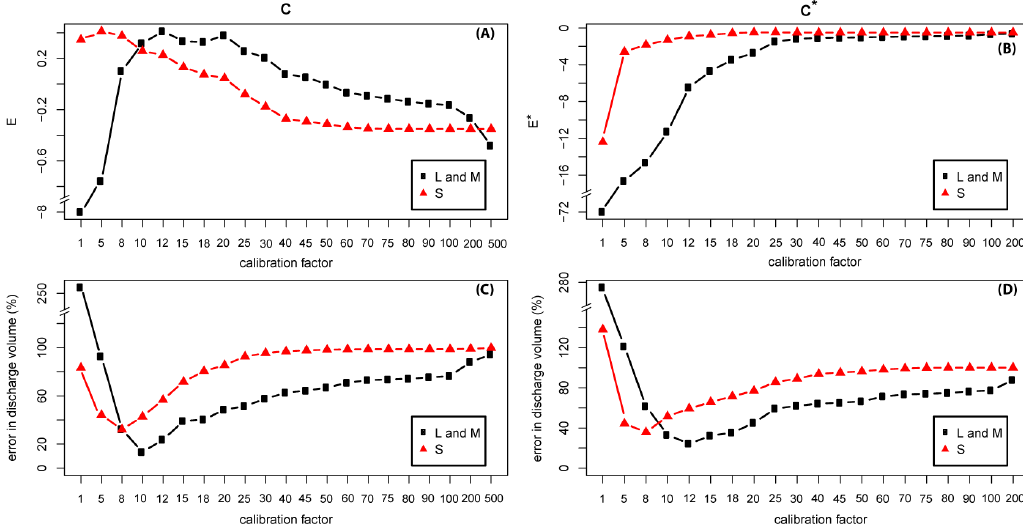
Fig. 8. Median of the Nash–Sutcliffe index, E ( A and B ), and discharge volume error as a percentage ( C and D ) calculated from events used for calibration ( y axis) as a result of different calibration factors ( x axis) for L and M catchments together (black line, rectangular dots), and S catchment (red lines, triangle dots) for the closure relation C and C ∗ .